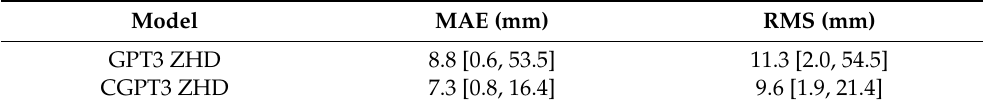
Table 2. Accuracy of ZHD derived from GPT3 and CGPT3 models for 148 sites from 2013 to 2016.